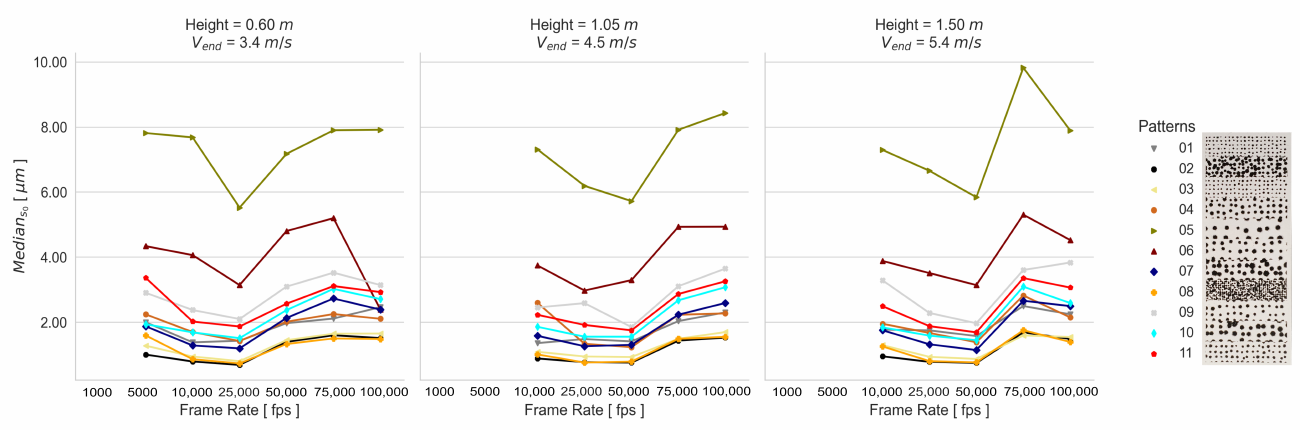
Figure 9. Median s 0 of the transformations obtained from the dynamic RP experimental configurations.